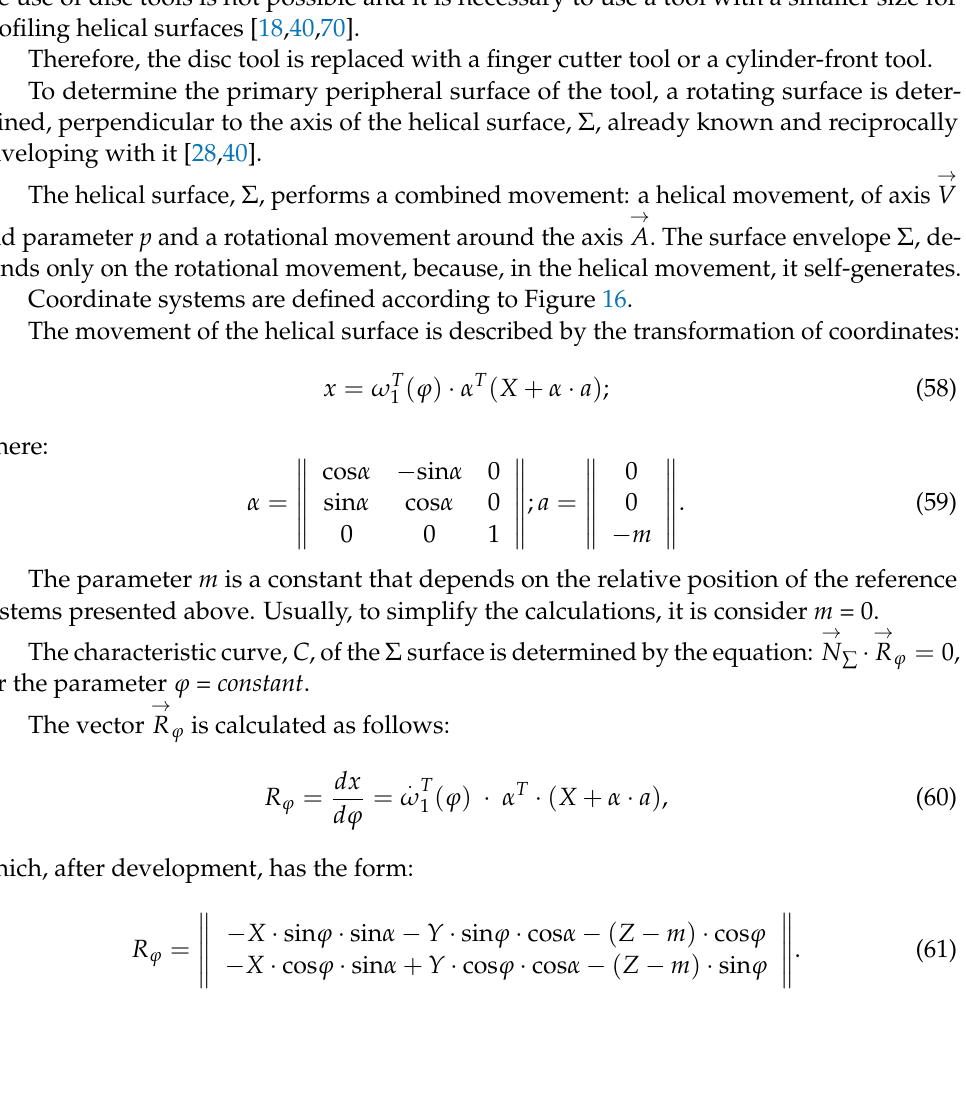
Figure 15. Generating kinematics with disc tool: movement I —rotational movement of the blank around its own axis, II —translational movement, along the same axis; III —cutting movement.